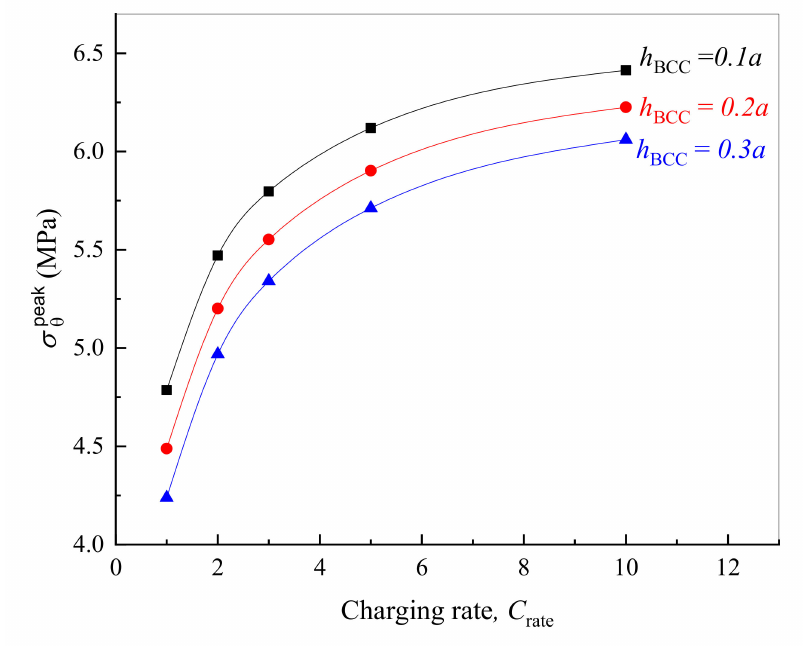
Figure 9. E ff ects of lithiation rate and BCC thickness ( h BCC ) on its peak